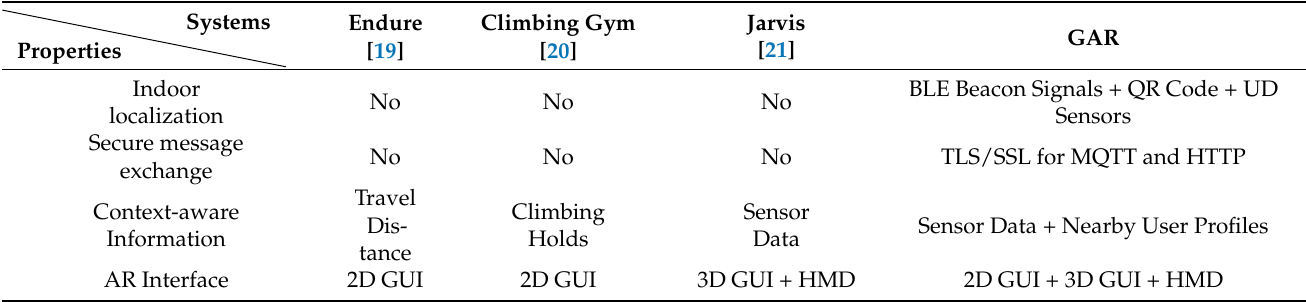
Table 1. Comparison of GAR and related